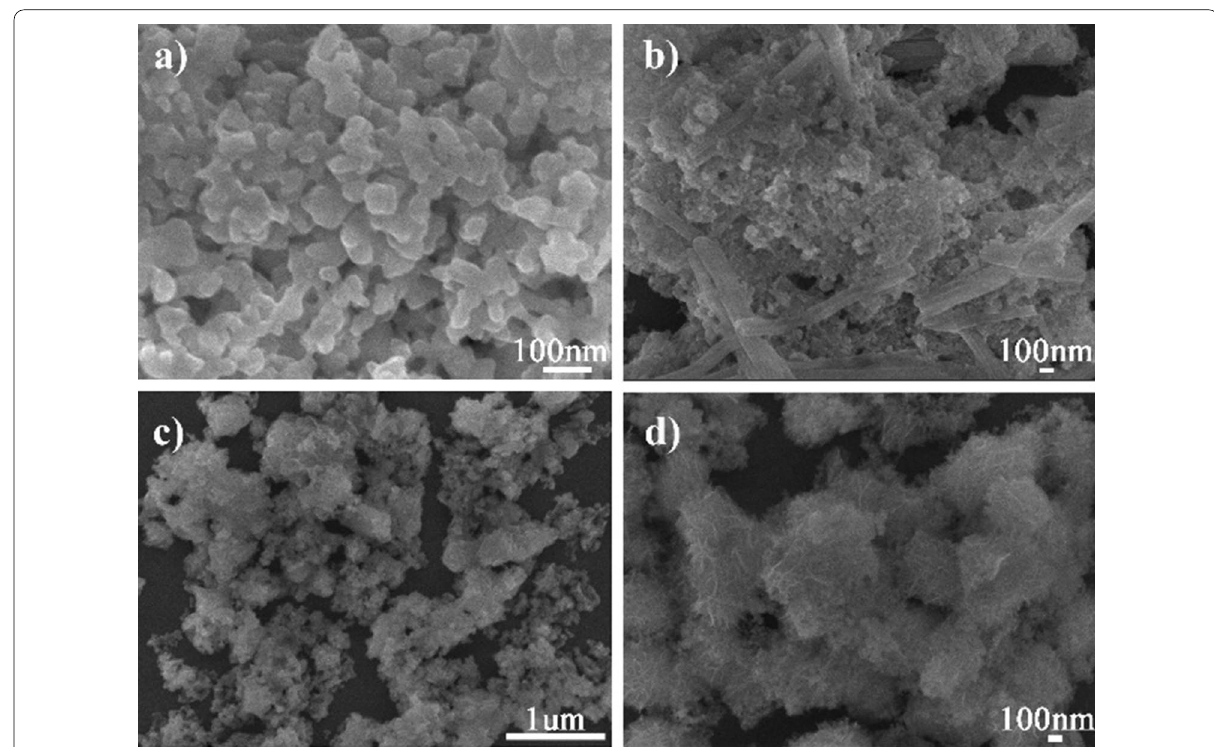
Fig. 3 SEM images of CeCdW 12 nanoflowers which prepared under different pH values (the pH values from a to d is 2, 3, 4 and 7, respectively)